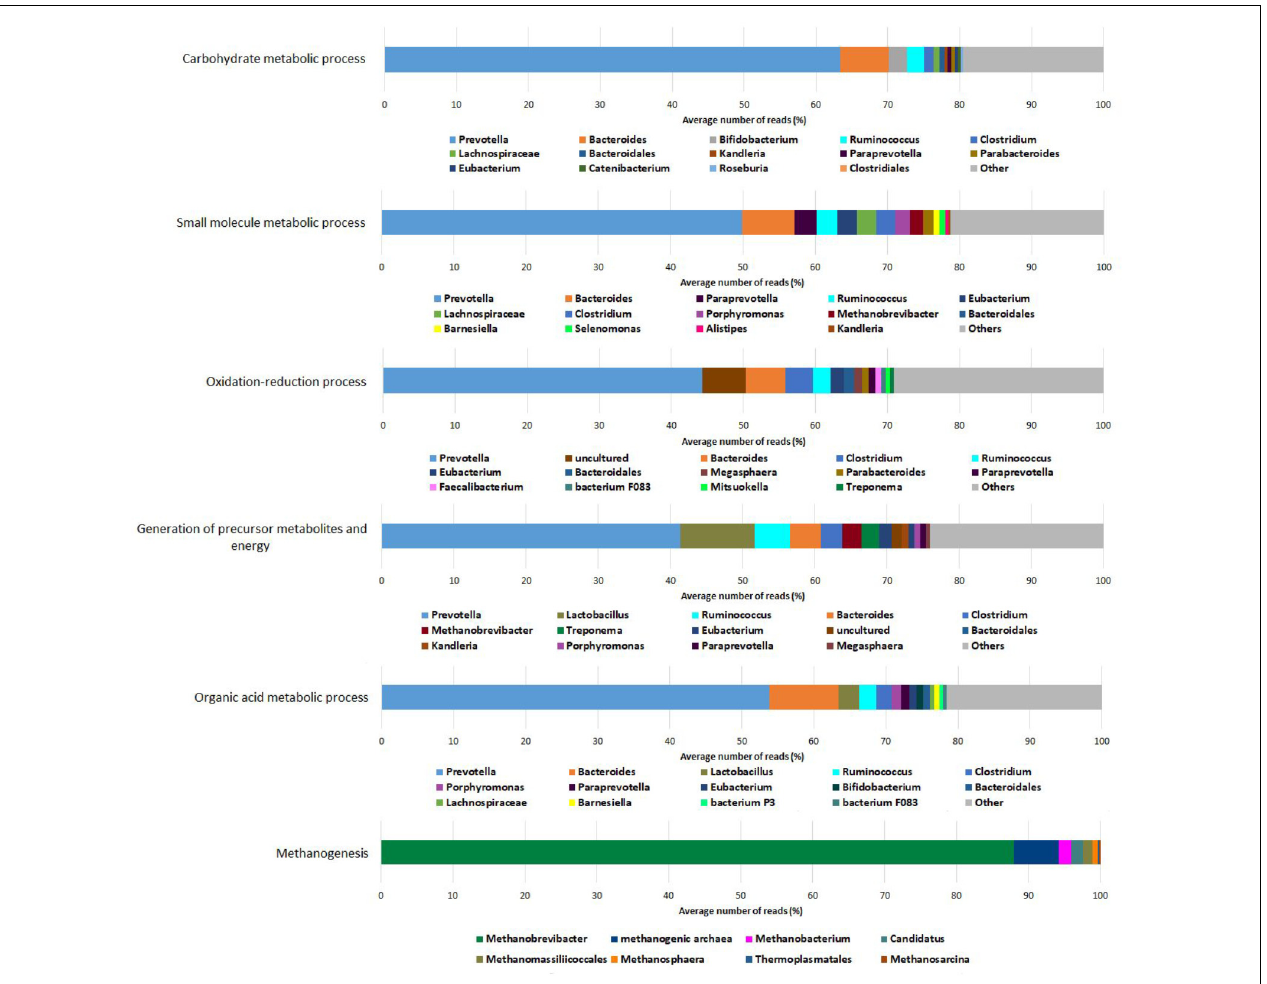
FIGURE 5 | Coupling functional groups to taxonomic genera determined from the metatranscriptomic